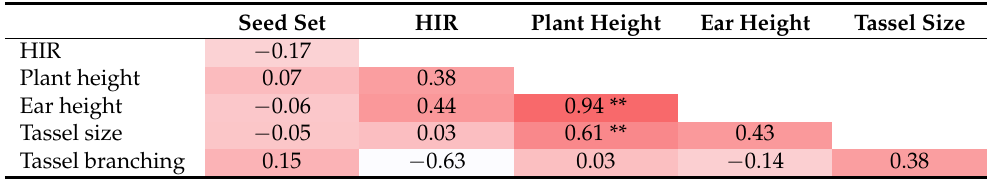
Table 6. Linear correlation among phenotypic traits of 16 haploid inducer genotypes evaluated at the second planting date of 2018.